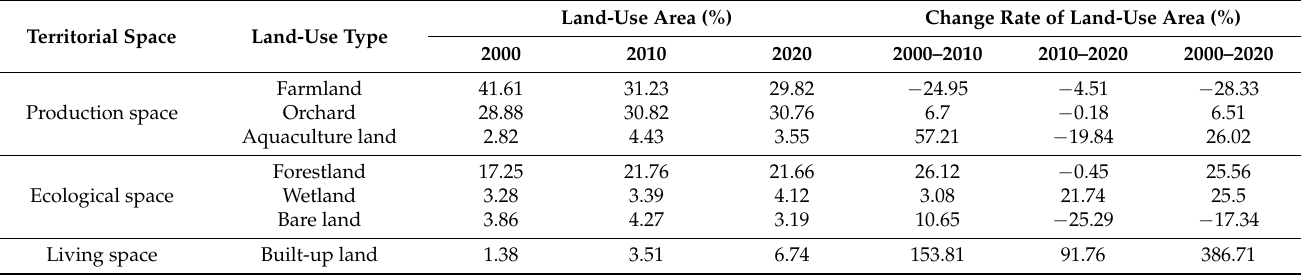
Table 5. Land-use area and their changes during 2000 and 2020 in the study